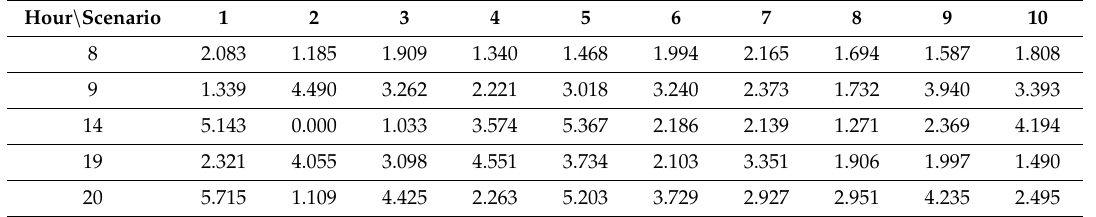
) of the fleet of electric vehicles for Case_2. st